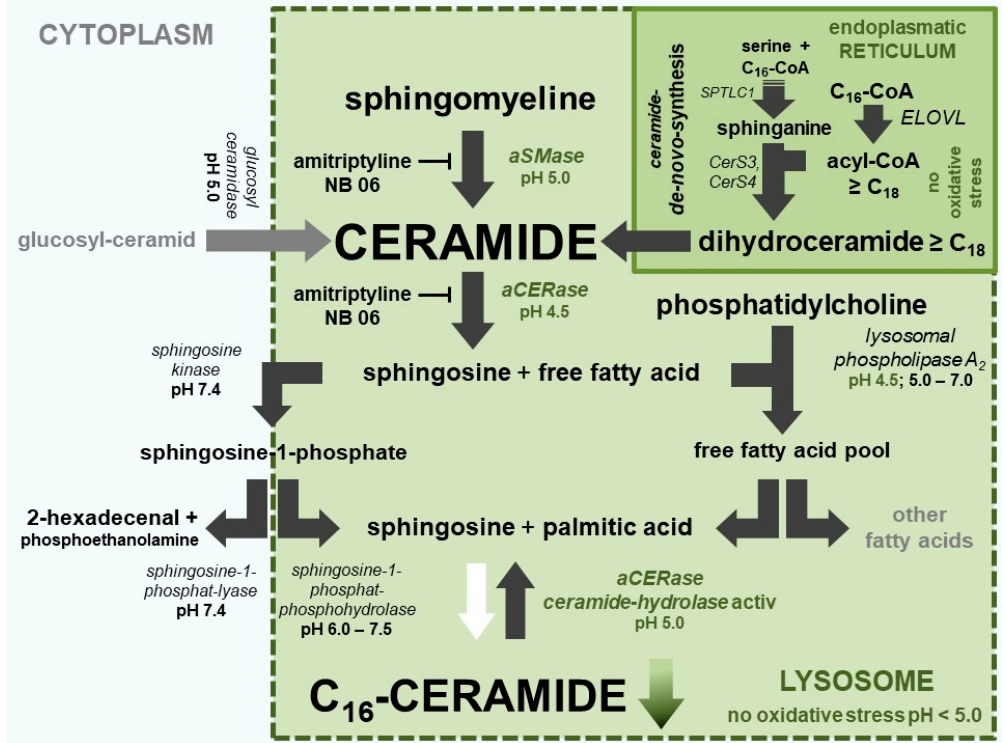
Figure 2. Ceramide metabolism in keratinocytes. Active pathways are marked with black arrows and inactive pathways are marked with white arrows. The objective of the ceramide metabolism-centered therapeutic concept is to use appropriate compounds to maintain lysosomal NADH-dependent redox chain, V-ATPase activity, and very long-chain ceramide de novo synthesis at the endoplasmic reticulum to prevent formation of pro apoptotic C 16 -ceramide in